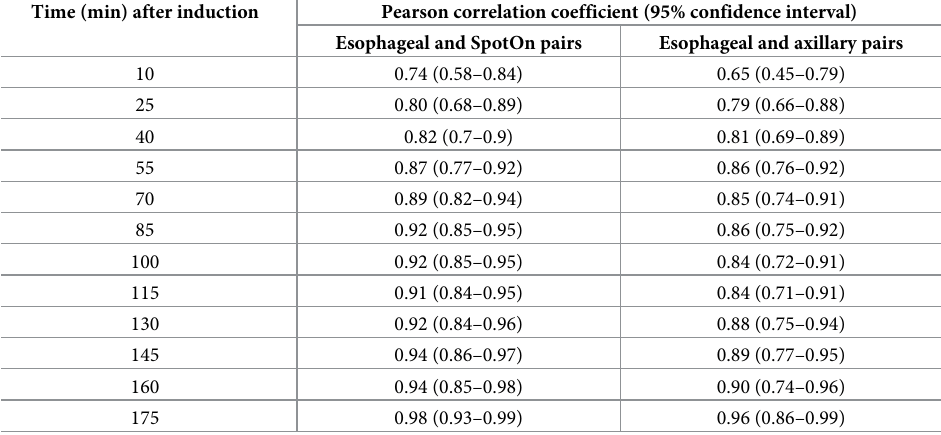
Table 2. Correlation analysis of esophageal temperature and SpotOn sensor, and esophageal temperature and axillary temperature divided by time after induction. Time (min) after induction